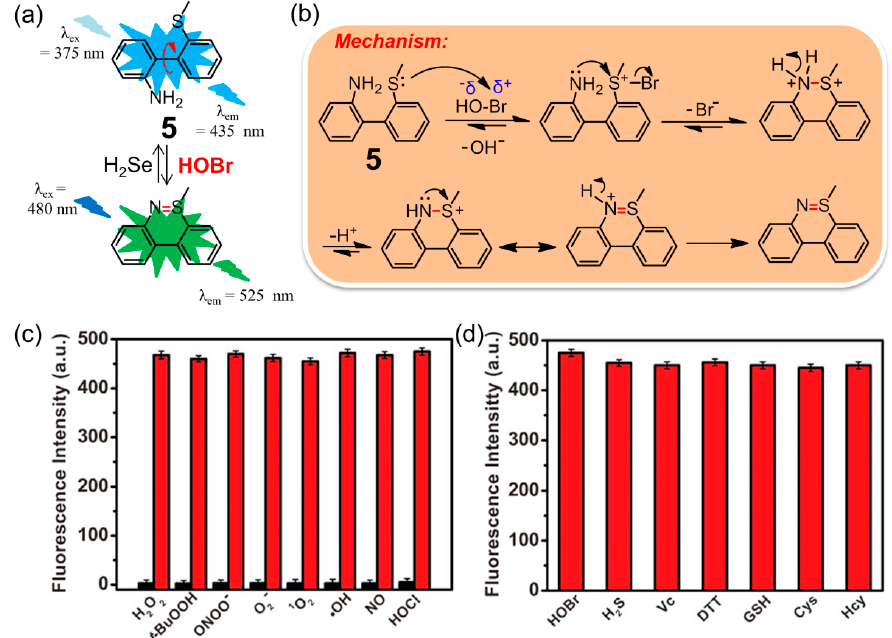
Figure 6. ( a ) Fluorescent probe 5 for selective recognition of HOBr followed H 2 Te; ( b ) the mechanism of oxidative cyclization of the amino group and S-methyl group catalyzed by HOBr; ( c ) fluorescence intensity of 5 after adding various active oxidizing species or ( d ) active reducing species. Reproduced with permission from Reference [76]. Copyright 2018 American Chemical Society.